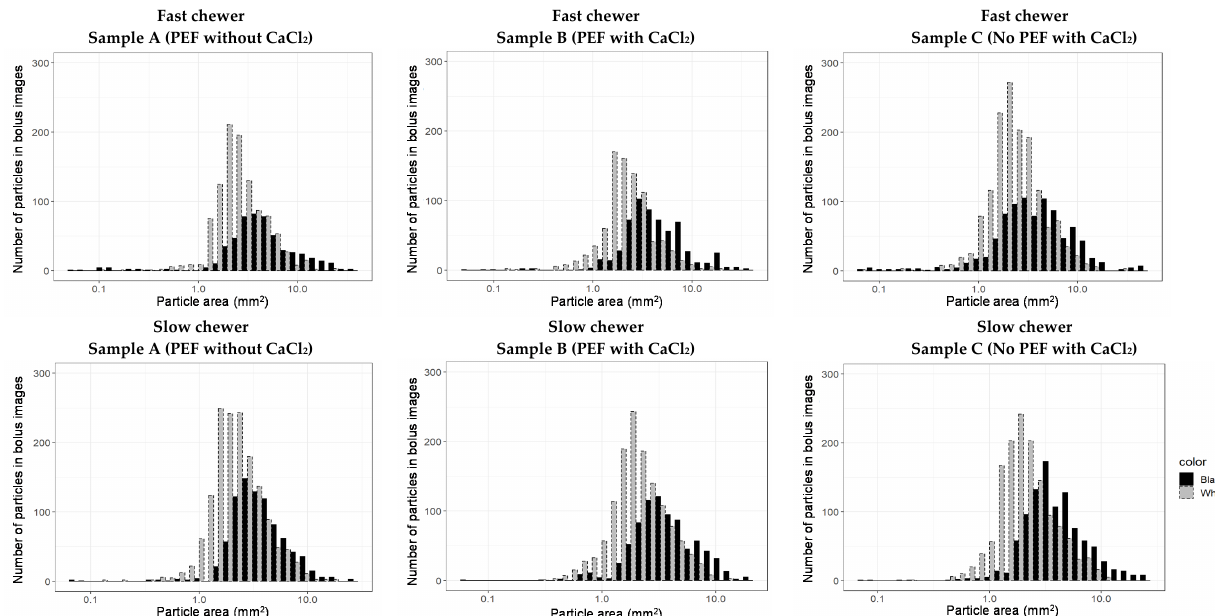
Figure 5. Representative examples of particle area distribution of separate components of black beans (black: seed coat, white: cotyledon) from the three samples (A: PEF and thermally processed without CaCl 2 addition; B: PEF and thermally processed with CaCl 2 addition; and C: No PEF, thermally processed with CaCl 2 ) as masticated by a fast chewer (participant 2) and a slow chewer (participant 12).